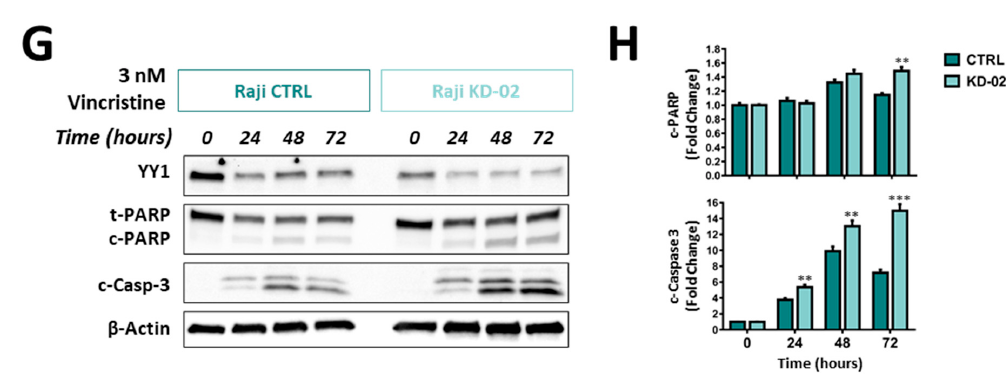
Figure 6. ( A ). Doxorubicin concentration-response treatment in Raji CTRL and KD-02 (knock-down for YY1 ). ( B ). Viability of Raji CTRL and KD-02 at Doxorubicin 10, 40 and 160 nM (doses around the CTRL and KD-02 IC 50 s). ( C ). Vincristine concentration-response treatment in Raji CTRL and KD-02. ( D ). Viability of Raji CTRL and KD-02 at vincristine 1.2, 3.7 and 11 nM (doses around the CTRL and KD-02 IC 50 s). ( E ). Western blot analysis of Raji cells non-silenced (CTRL) and silenced for YY1